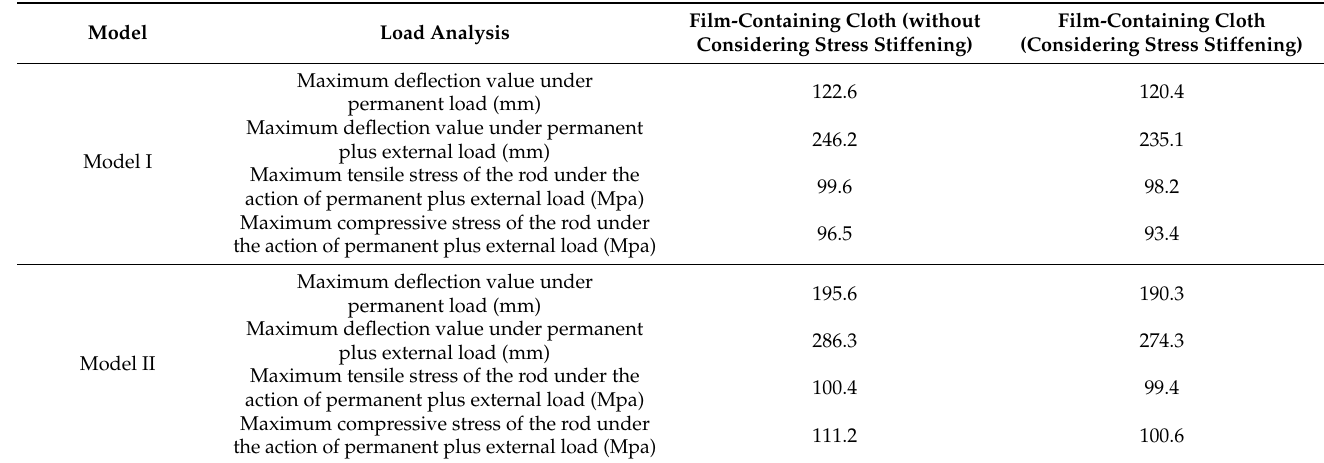
Table 5. Comparison of stiffness values under stress stiffening for the two